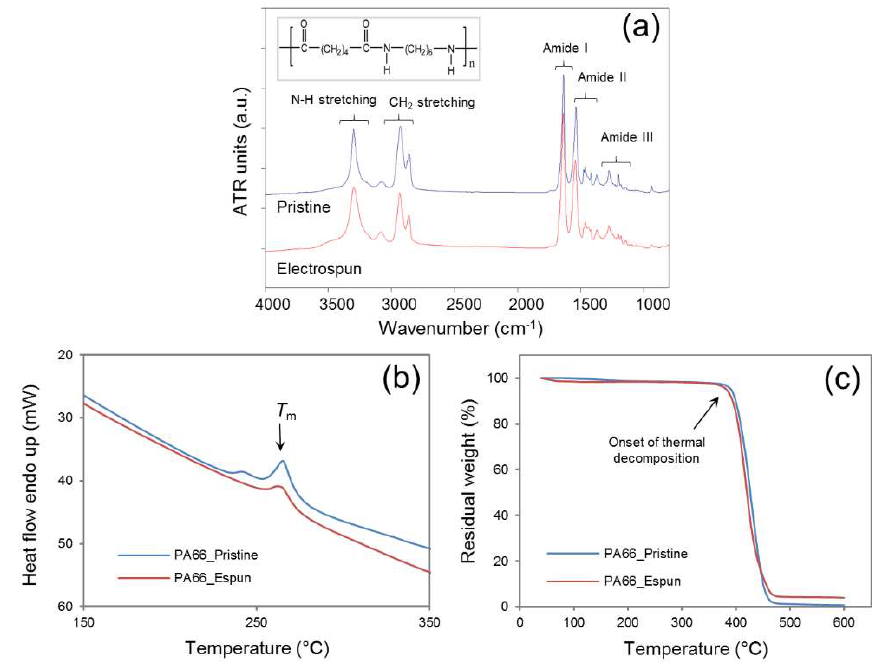
Figure 4. Material characteristics before and after sacrificial core electrospinning: Attenuated Total Reflection-Fourier-transform infrared spectroscopy (ATR-FTIR) ( a ), and thermogravimetry /differential thermal analysis (TG/DTA) ( b —DSC, c —TGA) confirmed that the use of sodium chloride within the collector has no significant influence on the bulk properties of the polymer (PA66).